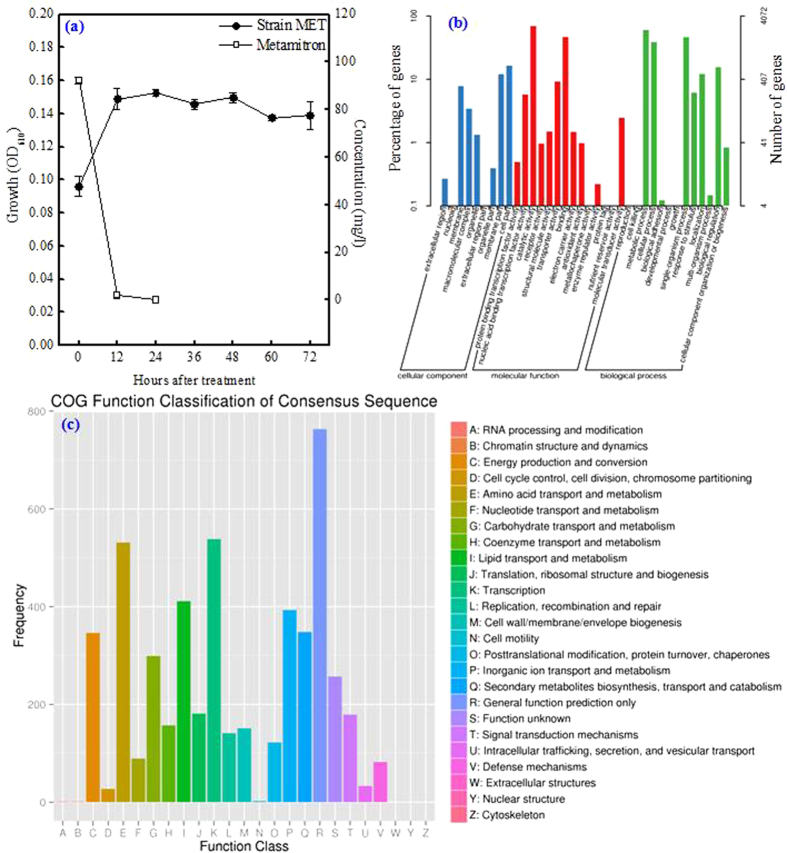
Growth of the isolate MET in mineral salts medium supplemented with 100 mg/l of metamitron at pH 7.0 and 30 °C (a), genome function annotation of the isolate MET against the Gene Ontology (GO) database (b), and genome function classification of the isolate MET against the Clusters of Orthologous Groups (COG) database (c).